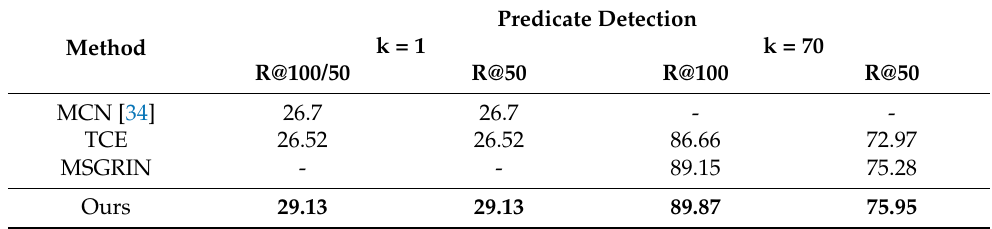
Table 2. Comparison with previous methods on the VRD zero-shot set; bold font indicates the best results.